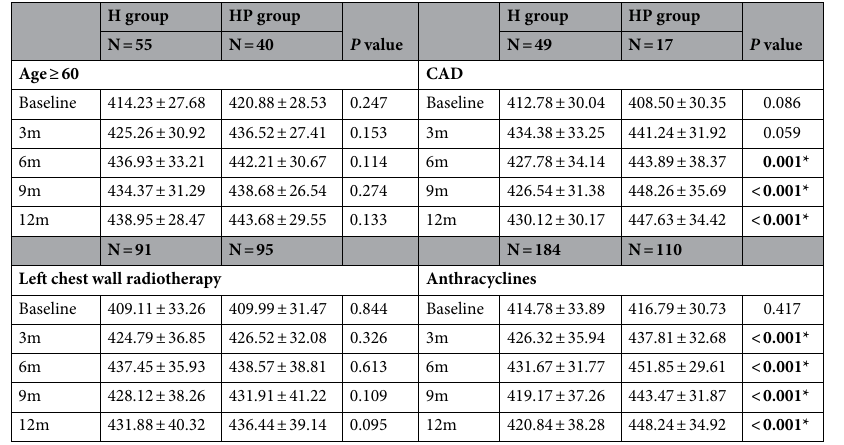
Table 6. QTc of patients in H group and HP group under various risk factors. Significant values are in [bold]. m month. * P <